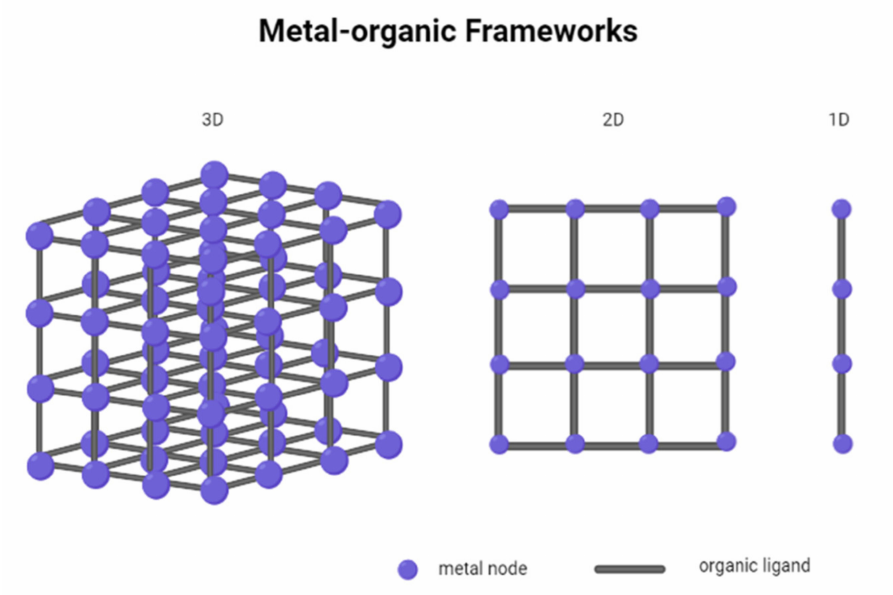
Figure 1. Structures of compound coordinated metal ions and organic binder arrangements shown in up to three